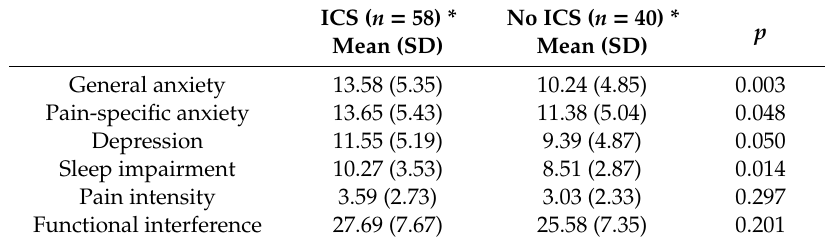
Table 7. Comparison of individuals who met criteria for implied central sensitization (ICS) and those who did